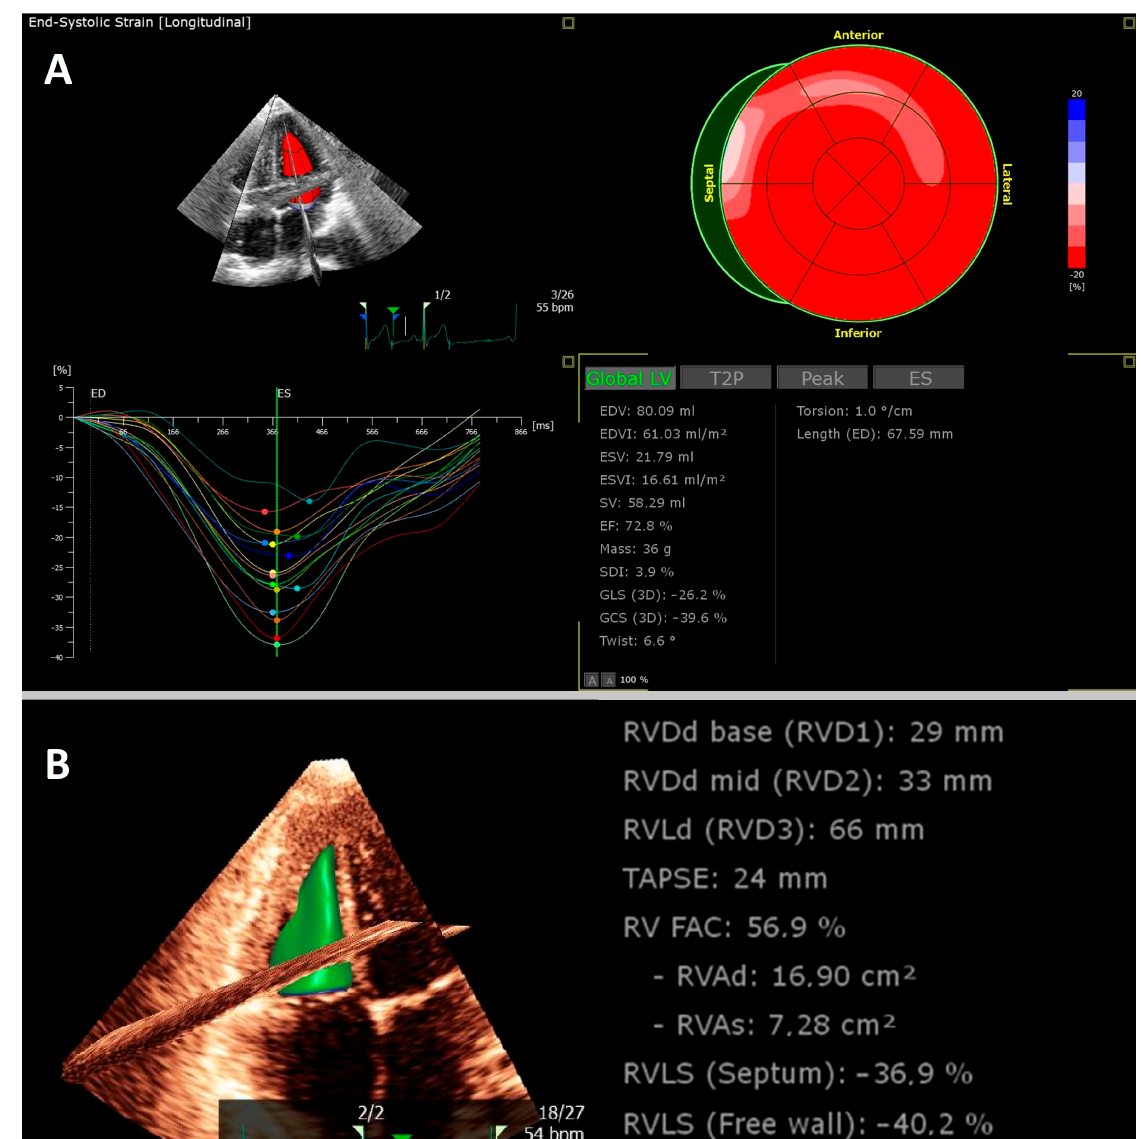
Figure 2. Example of a young athlete who was examined after COVID-19 before returning to sport. Transthoracic 3D echocardiography revealed normal left ventricular ( A ) and right ventricular function ( B ).